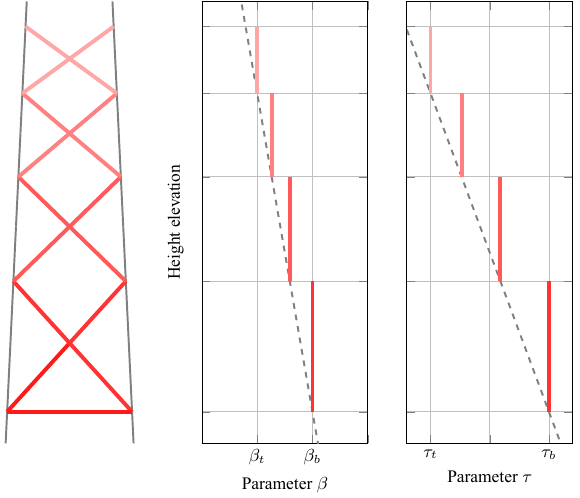
Figure 4. Definition of leg dimensions with a dependency on the jacket height. Values are illustrated by darker coloring at the bottom and shade to lighter at the top of the structure.